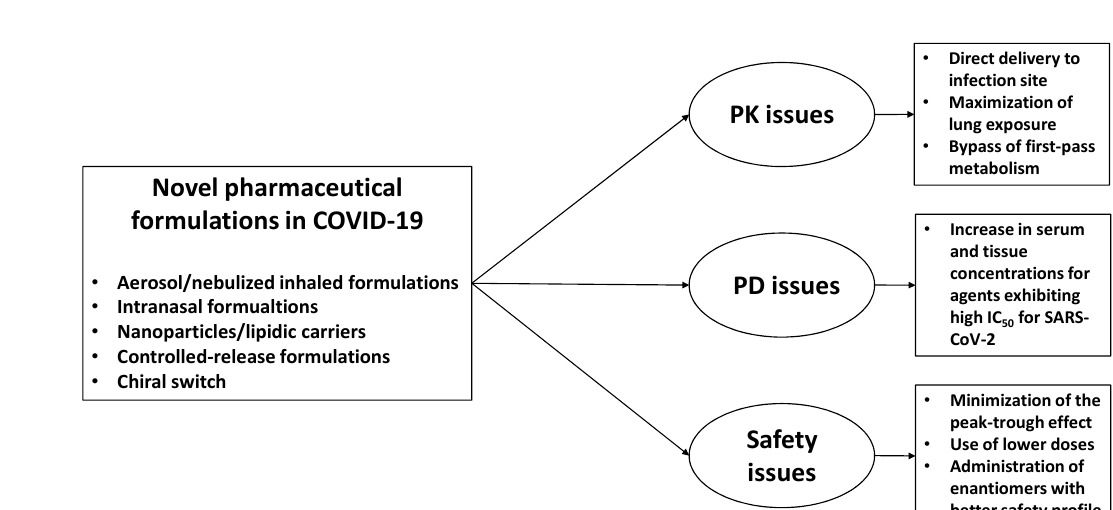
Figure 2. Relationship between pharmaceutical formulations and pharmacokinetic/pharmacodynamic properties affecting efficacy and safety of repurposed agents in respiratory viral diseases, including COVID-19 setting. PK, pharmacokinetic; PD, pharmacodynamic.